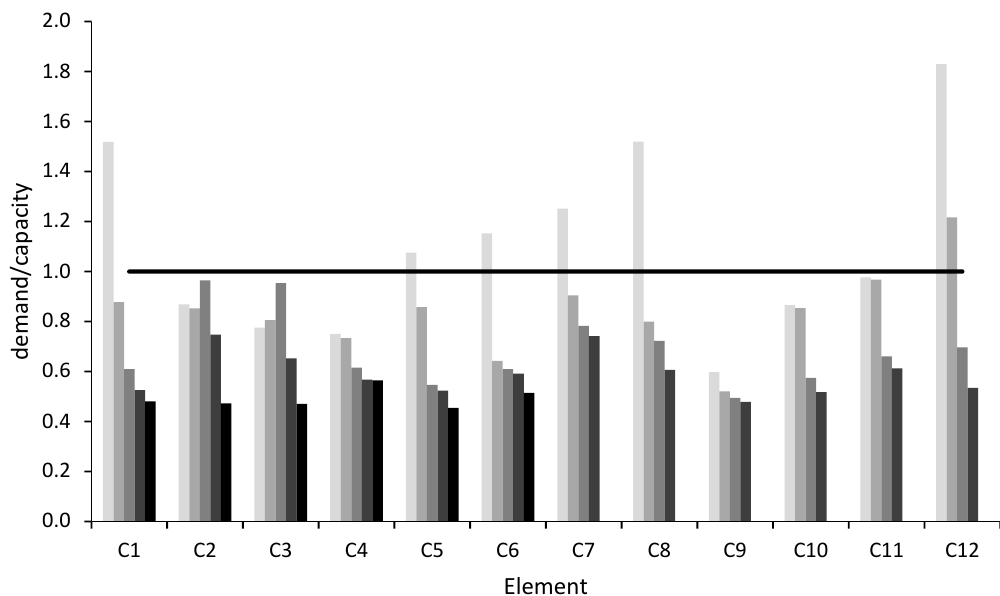
Buildings 2020 , 10 , x Figure 5. Combined bending and compression verifications of columns in as-built condition.